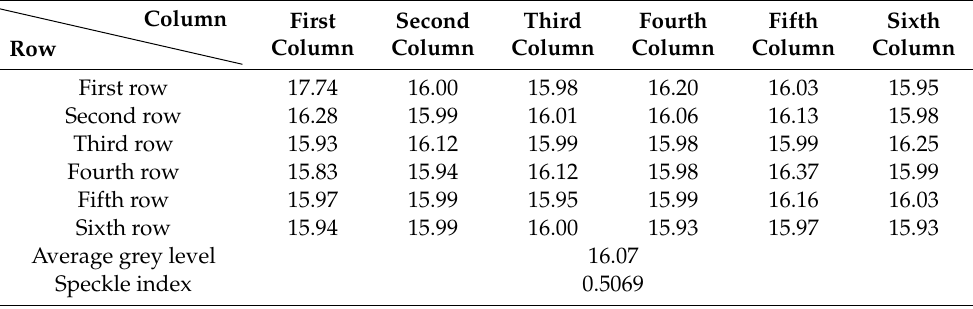
Table 2. The average gray value corresponding to the sample point before filtering.